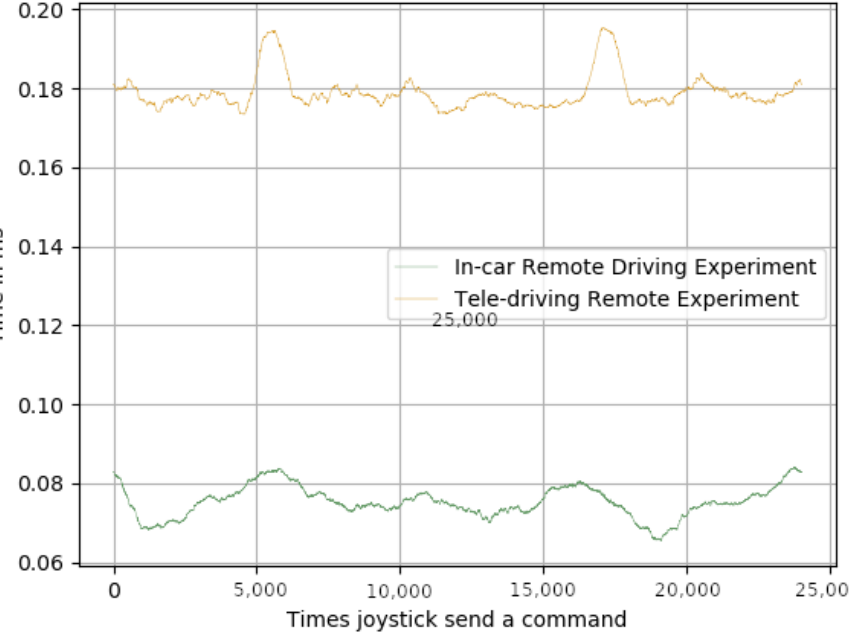
Figure 6. Time in ms from when the joystick was pressed until command was sent over the network.